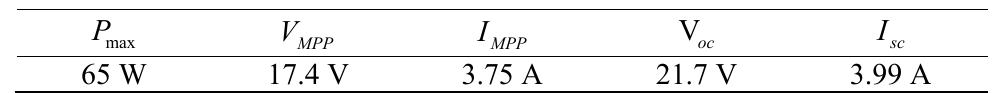
Table 1. KC65T data